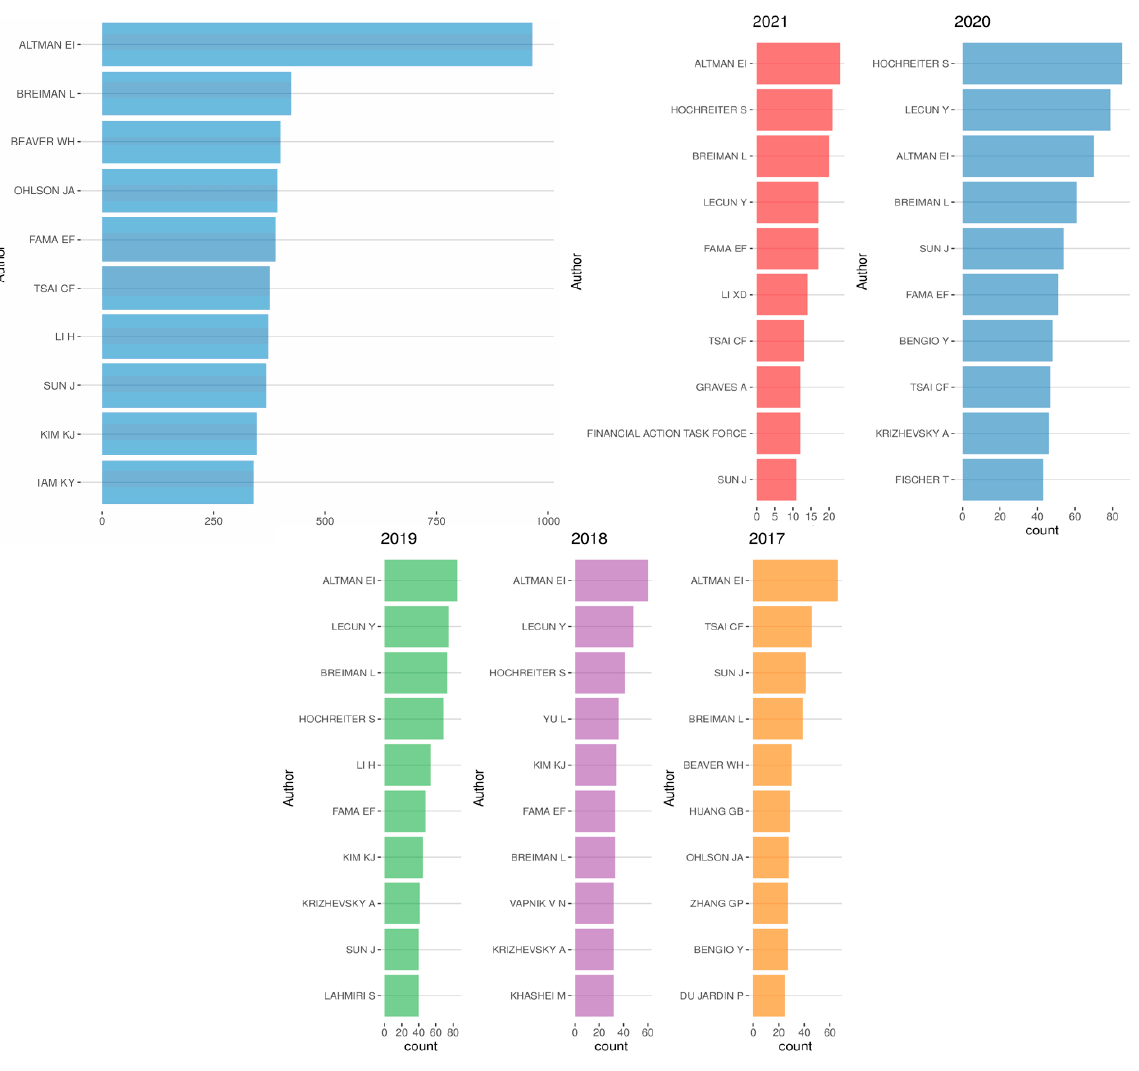
Figure 8. Analysis of cited references, overall period, and per year.